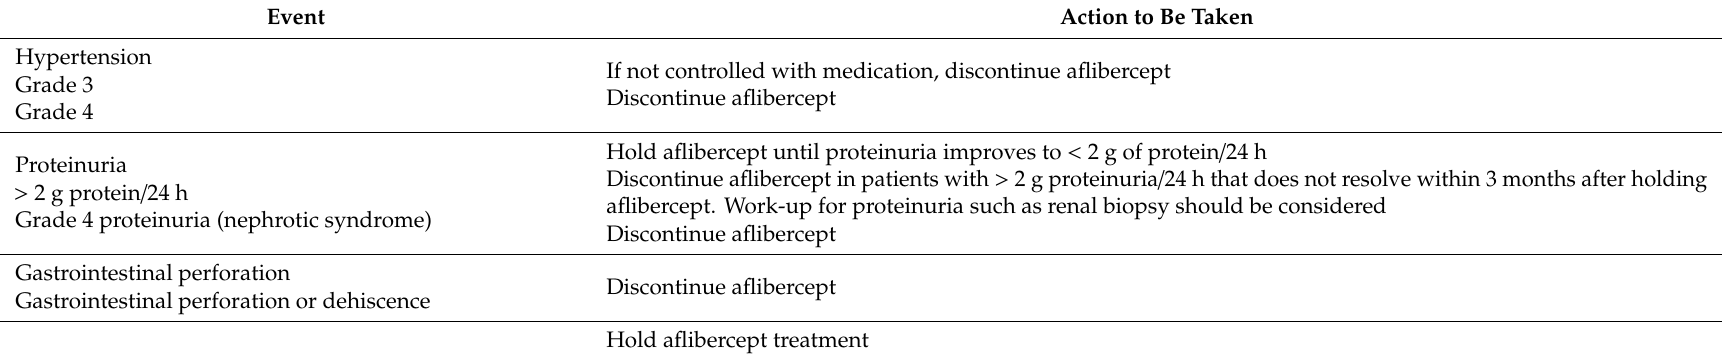
Table 3. General guidelines for aflibercept dosing and schedule modification due to adverse events as categorized by CTCAE 4.0 *